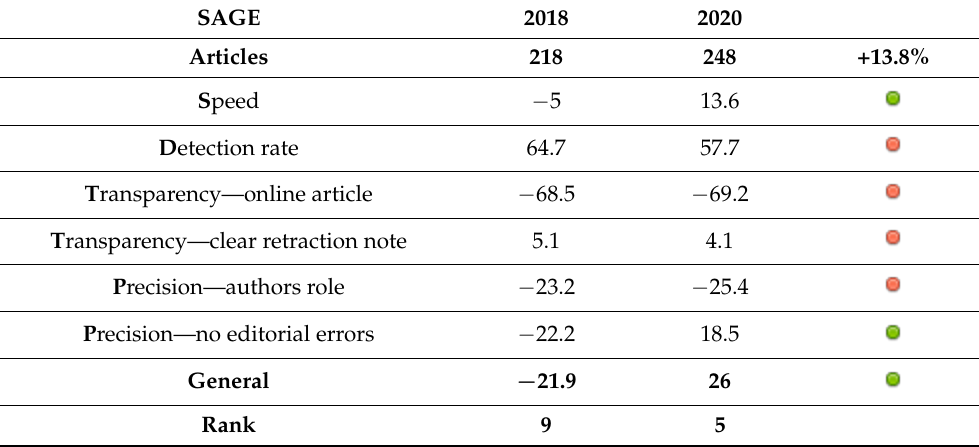
Table 15. Elsevier 2018 – 2020 change of SDTP score. Table 16. Springer Nature 2018 – 2020 change of SDTP score.